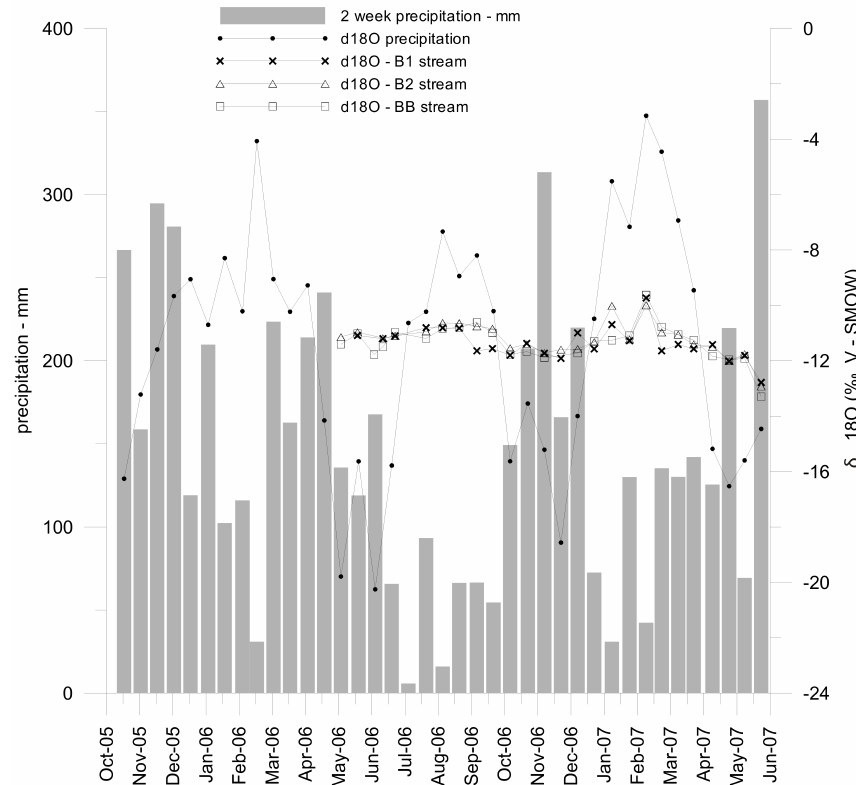
Fig. 3. Isotopic signal in precipitation and streams compared with the amount of precipitation for 2-week